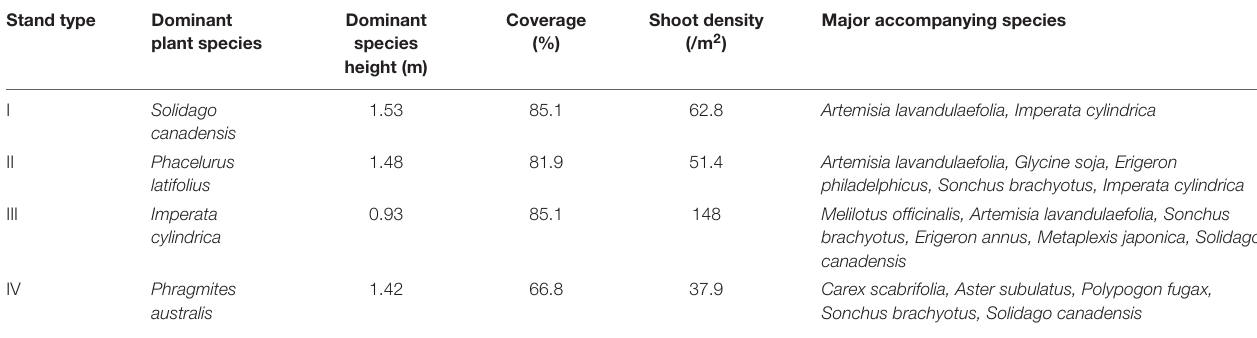
TABLE 1 | Characteristics of the four stand types. Stand